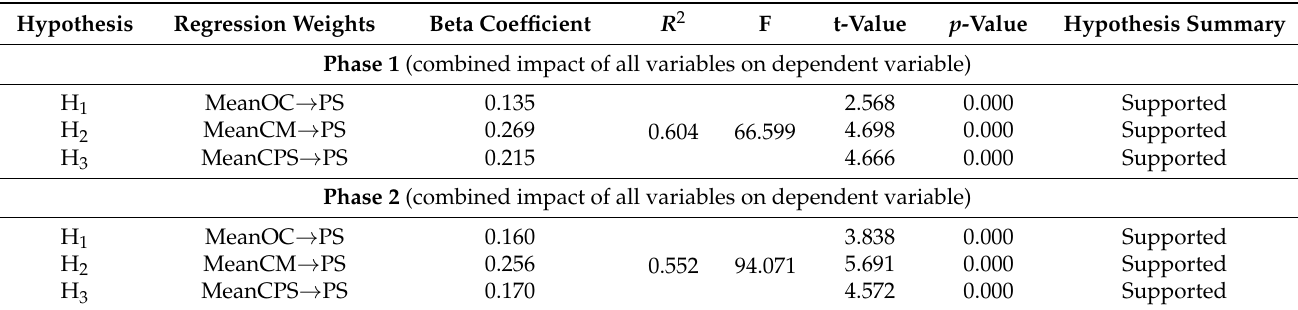
Table 7. Multiple regression